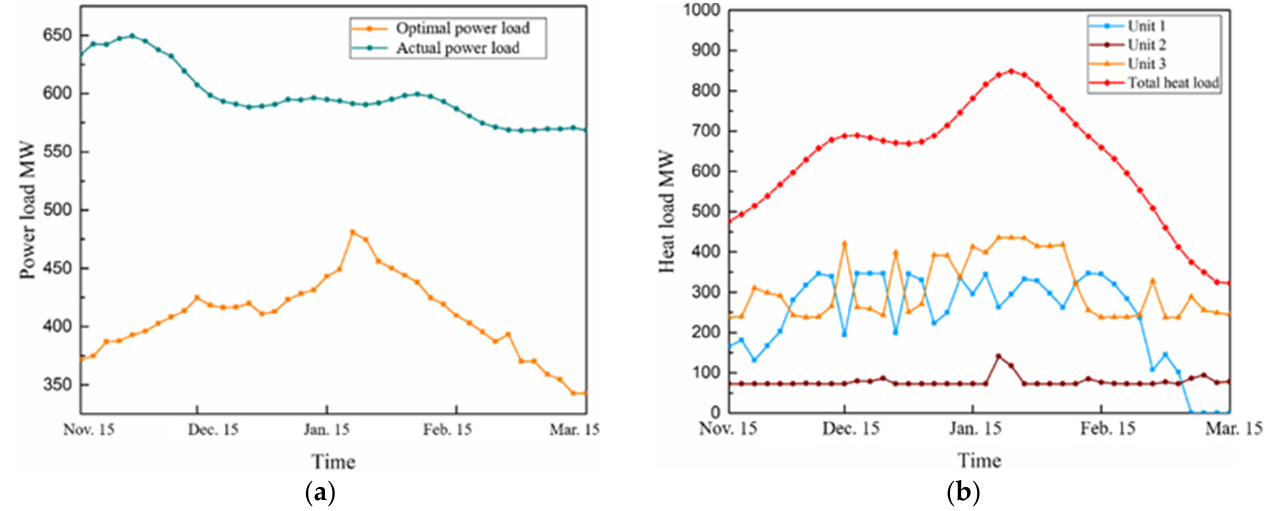
Figure 10. Optimization results. ( a ) Optimal power load, ( b ) optimal heat load.